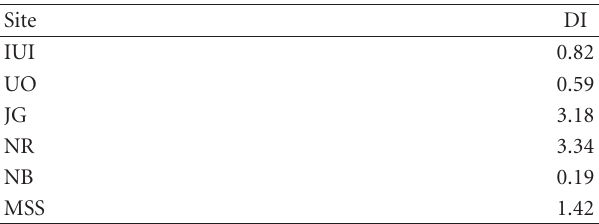
Table 6: DI values obtained from